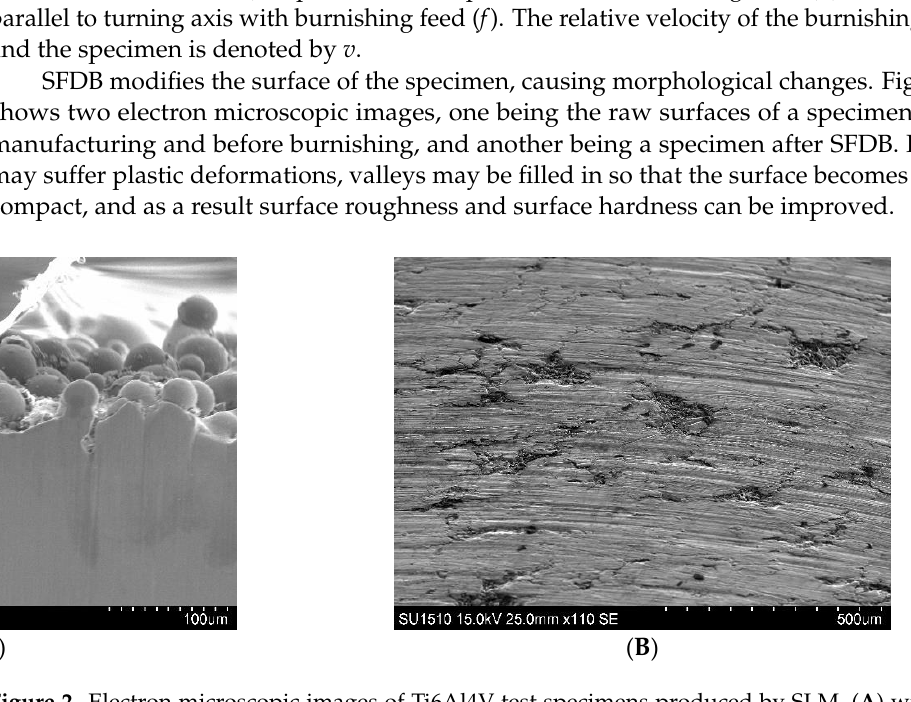
Figure 1. Design of test specimens and measurement pathways. Linear dimensions are given in mm. Orange numbers are not dimensions, but ordinal numbers of reference circles. “Sign” means that letters A – E are printed onto the end of each specimen, denoting which group it belongs to. See Table 1 for details. Table 1. Infill laser power ( P ) and infill laser scan speed ( u ) values applied for groups of test speci- mens denoted by A – E, and energy input ( e ) calculated from SLM parameters.